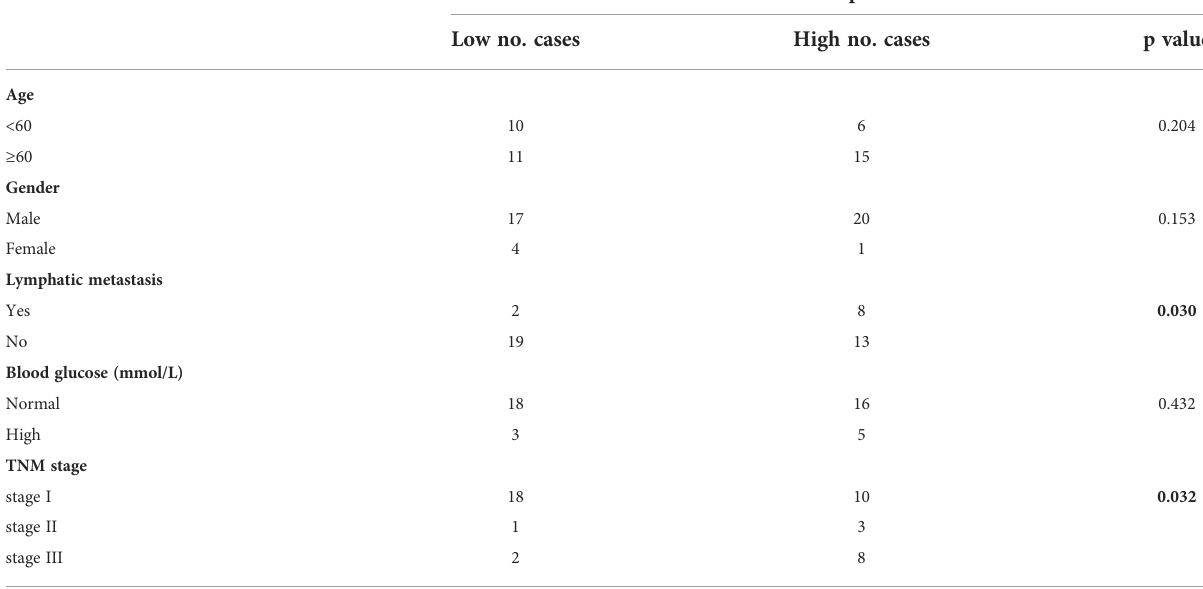
TABLE 2 Correlation between DEPDC1 expression and clinicopathologic characteristics of OSCC patients.